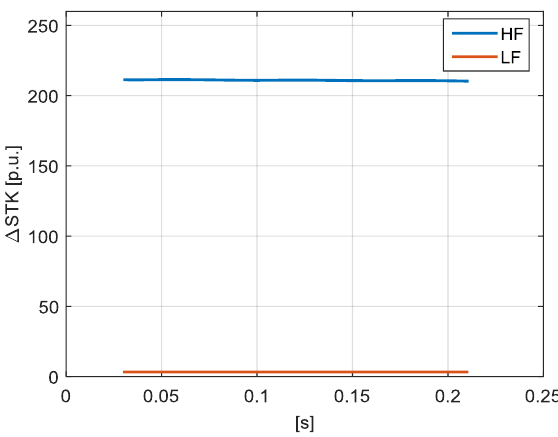
Figure 9. Case study 1: Δ STK at low-frequency (0 ÷ 2 kHz, red line) and at high-frequency (2 ÷ 150 kHz, blue line) obtained by the late approach.